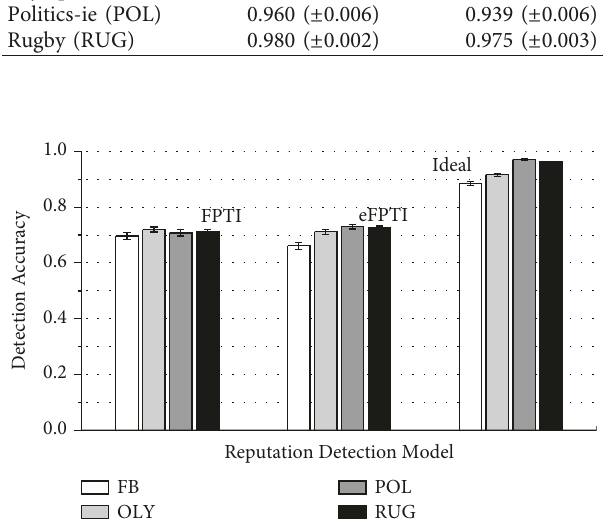
Figure 8: Detection accuracy in twitter